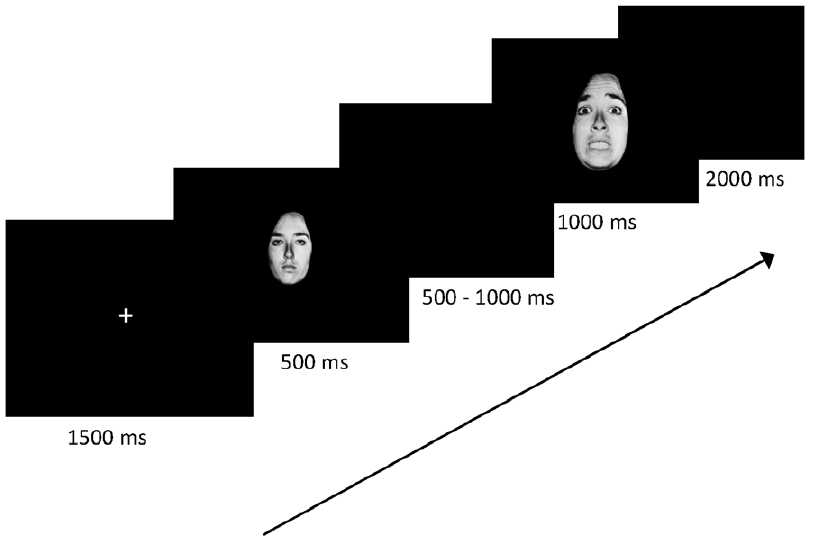
Figure 1. Trial presentation. The example shows a cue followed by a Nogo stimulus. In the event of an error, a period of 1500 ms is allowed for subsequent error verification.